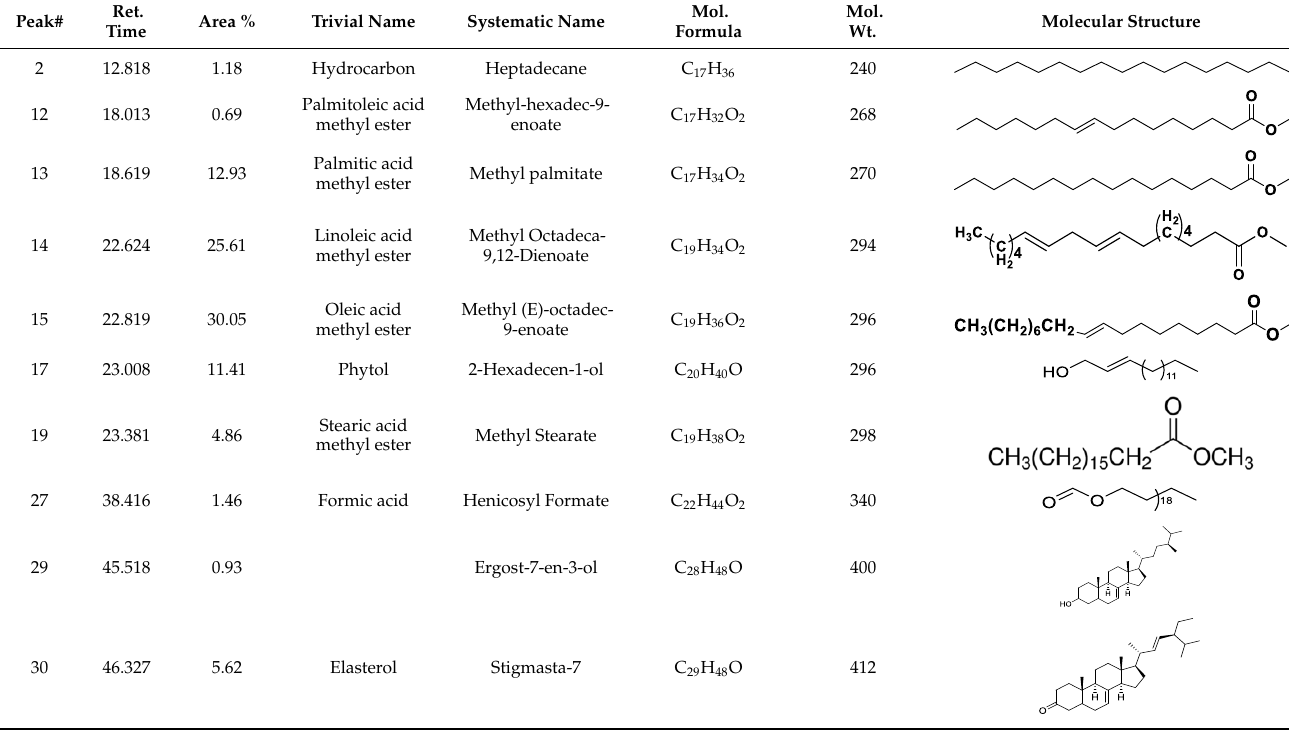
Table 3. FAME profile derived from Scenedesmus rotundus -MG910488.